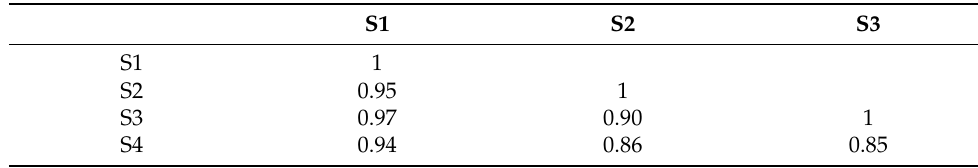
Table 3. Correlation coefficients for utility scores, 2010.